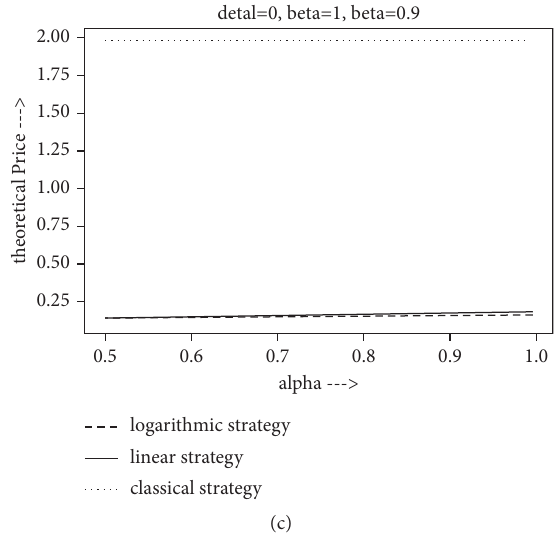
� 0.3, 0.6, or 0.9 (a, b, c), respectively.